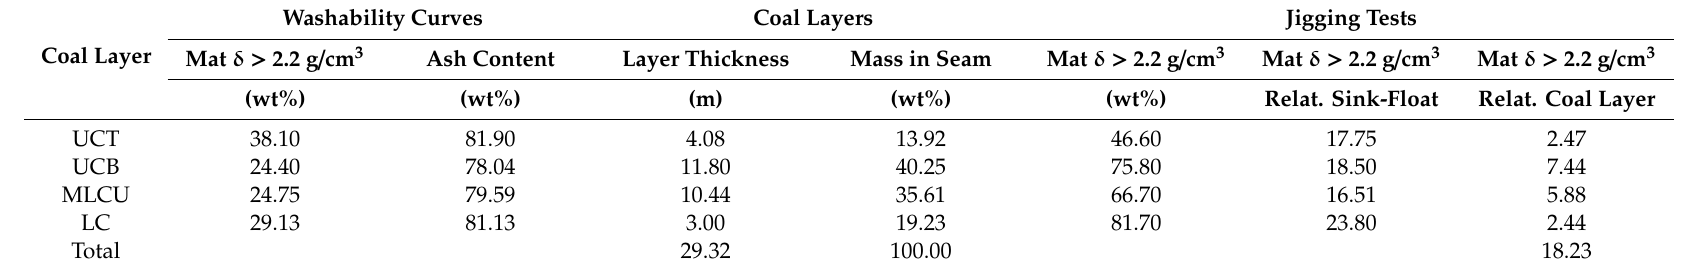
Table 5. Mass balance of the washability curves, coal layers, and of the jigging